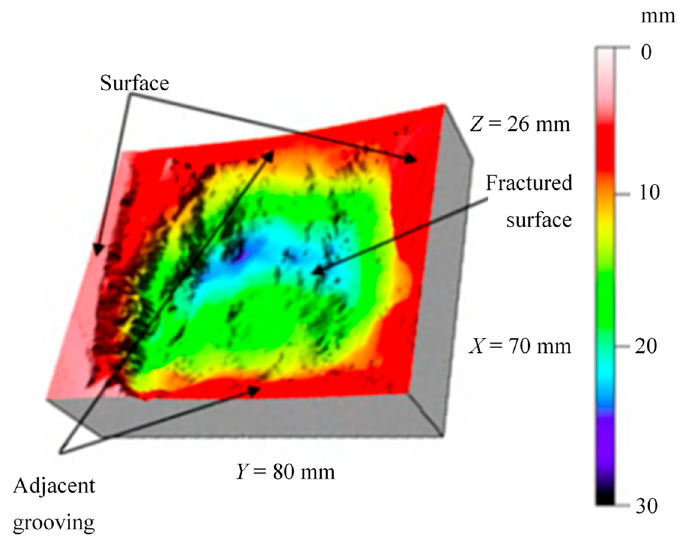
Figure 5. A typical fractured surface.